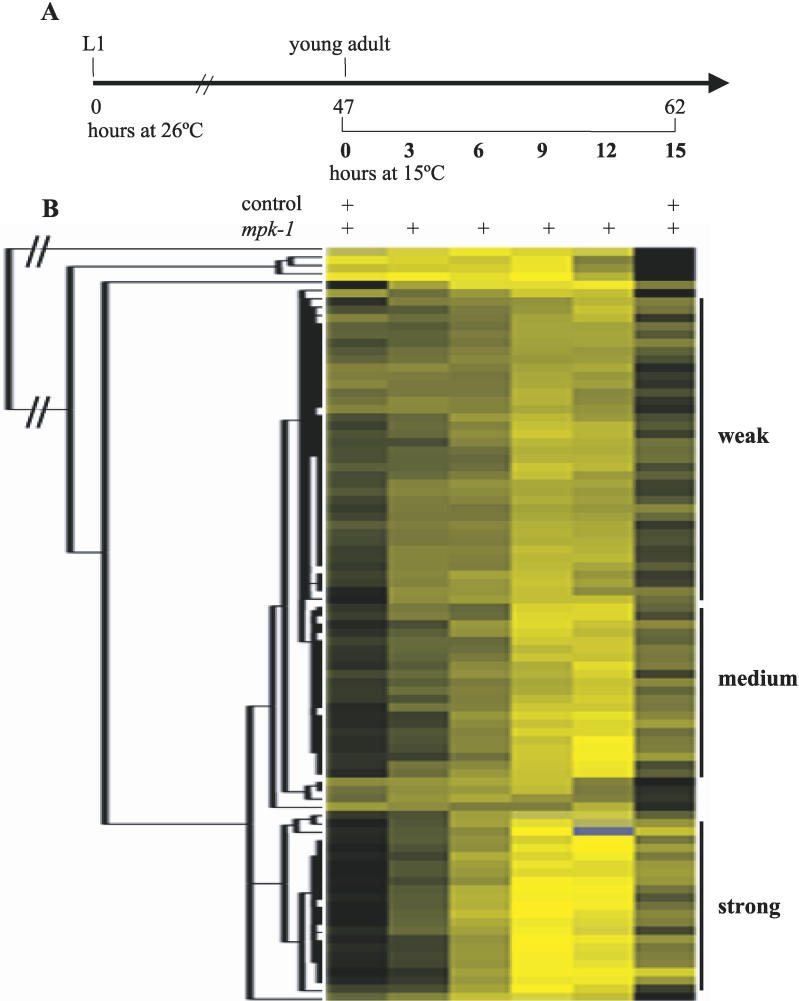
Temporal Expression Profiling of Meiotic Progression(A) Adults were shifted to permissive temperature (47 h after hatching) and subsequently analyzed at indicated times.(B) Hierarchical clustering analysis of expression profiles upon resumption of MPK-1 signaling. Each column represents the mean of three replicates for each time sampled. Each row represents one of 90 genes with enriched expression in control compared with mpk-1 at 0 h. Low expression in mpk-1 relative to the control (black) is evident at 0 h, with increasing expression as meiotic progression resumes (yellow). Three major clusters, each with an expression correlation > 0.95, are indicated (strong, medium, and weak).